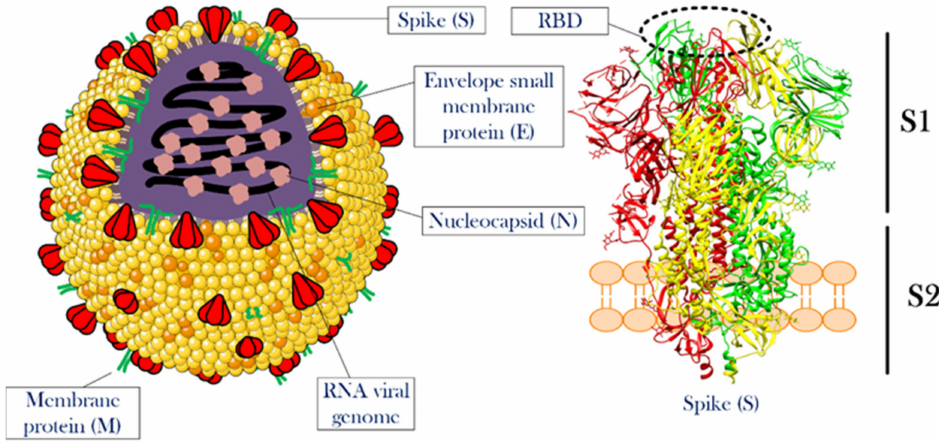
Figure 1. The overall structure of CoV and the spike protein. The left side illustrates a single particle of CoV. Three membrane proteins and RNA viral genome in a complex with nucleocapsid proteins were shown in the scheme. The right side shows the detailed structure of a spike protein. This protein, which is the most important functional protein during the attachment of the viral particle to the host cell, has two subunits named S1 and S2. The receptor-binding domain is located at the top of S1. For more information see the text. The structure of the spike protein was extracted from PDB 6ZGI [29]. RBD is receptor-binding